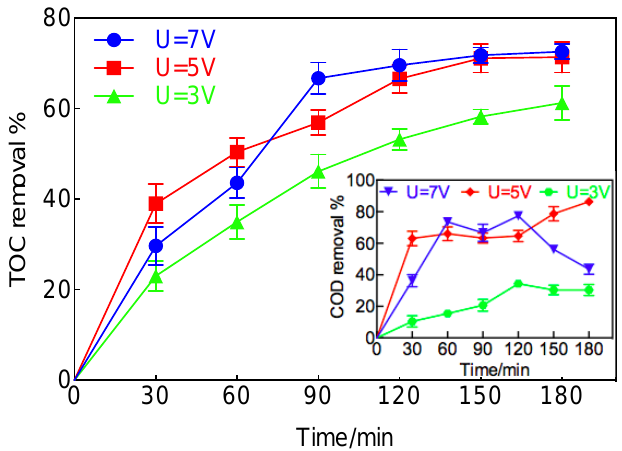
Figure 8. TOC and COD removal of RhB wastewater with different voltages in the recycling-flow 3D electro-reactor system (RhB wastewater initial concentration is 100 mg/L; volume is 500 mL; initial pH is 7; Na 2 SO 4 as an electrolyte, initial concentration is 2 g/L; HRT is 20 min).